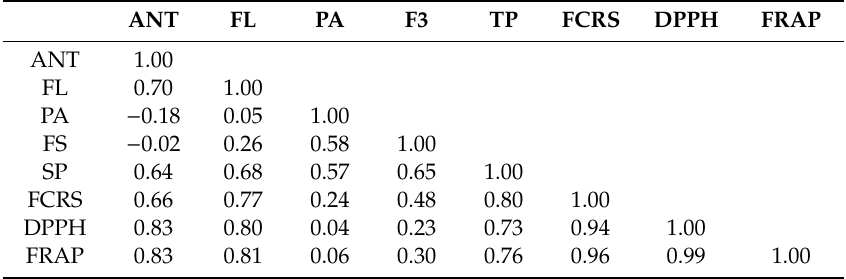
Table 5. Correlation coe ffi cients between phenolic compounds and antioxidant capacity tests. ANT FL PA F3 TP FCRS DPPH FRAP